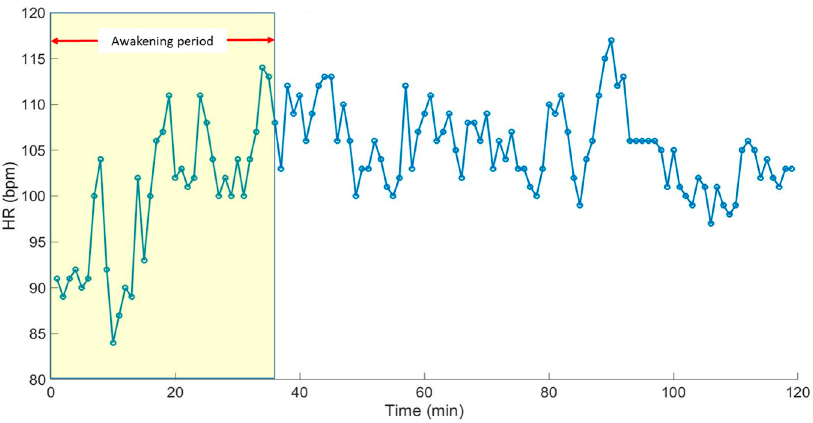
Figure 11. The estimated HR of the non-anaesthetised (moving) pig using the developed CWTFT-based algorithm along the whole measurement period, including the awakening